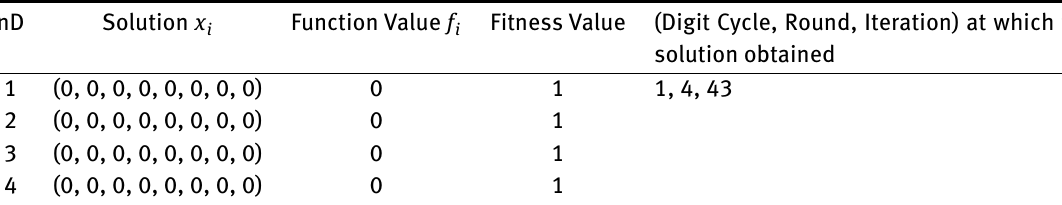
Table 12: Digit Cycle Results for Ackley’s function with 4 variables nD Solution x i Function Value f i Fitness Value (Digit Cycle, Round, Iteration) at which the